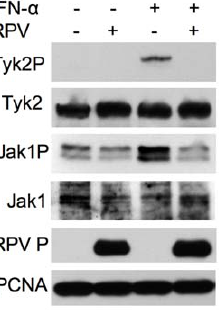
Figure 6. RPV-Sa infection blocks IFN a -induced phosphoryla- tion of Jak1/Tyk2. A549 cells were infected with RPV-Sa at a MOI of 5 or left uninfected. Eighteen hours post-infection cells were mock treated or treated with 1000 IU/ml of IFN a for 15 minutes, lysed in SDS- PAGE sample buffer containing protease and phosphatase inhibitors and the levels of phosphorylated Jak1 and Tyk2 were analyzed in Western blots using rabbit anti-Jak1P and rabbit anti-Tyk2P antibodies respectively. The blots were also probed with rabbit anti-Jak1, rabbit anti-Tyk2 and rabbit anti-RPV P protein (MB18) to analyze the total Jak1 and Tyk2 and to confirm RPV infection. The primary antibodies were detected with peroxidase-labelled anti-mouse or anti-rabbit IgG antibody. PCNA levels served as loading control.